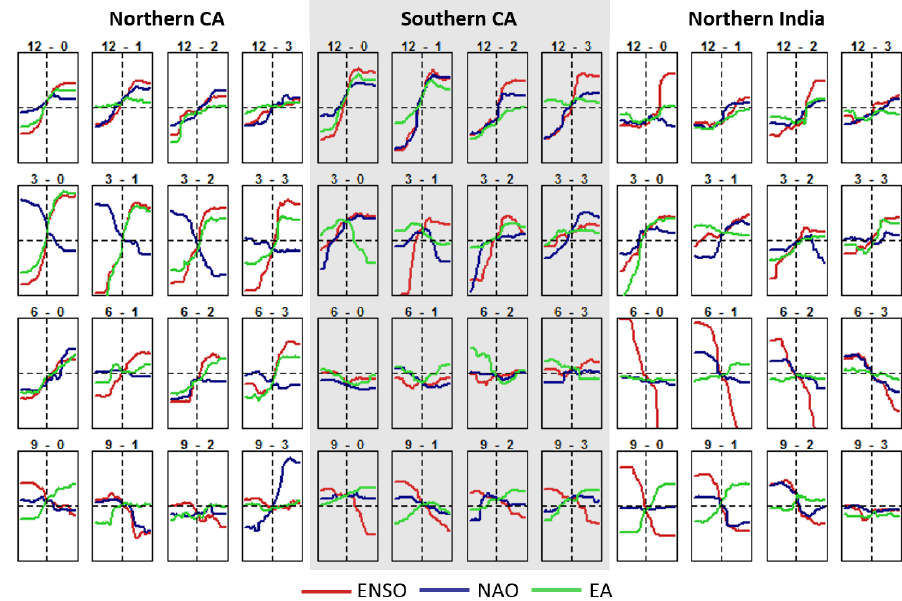
Figure 8. Results of sensitivity analysis for selected target regions, months and lead times (from 0 to 3 months). The x axis represents the range of the considered large-scale index (from − 2 to 2 standard deviations). The y axis indicates the model response to associated predictor variables (ranging from SPI =− 1 to SPI =